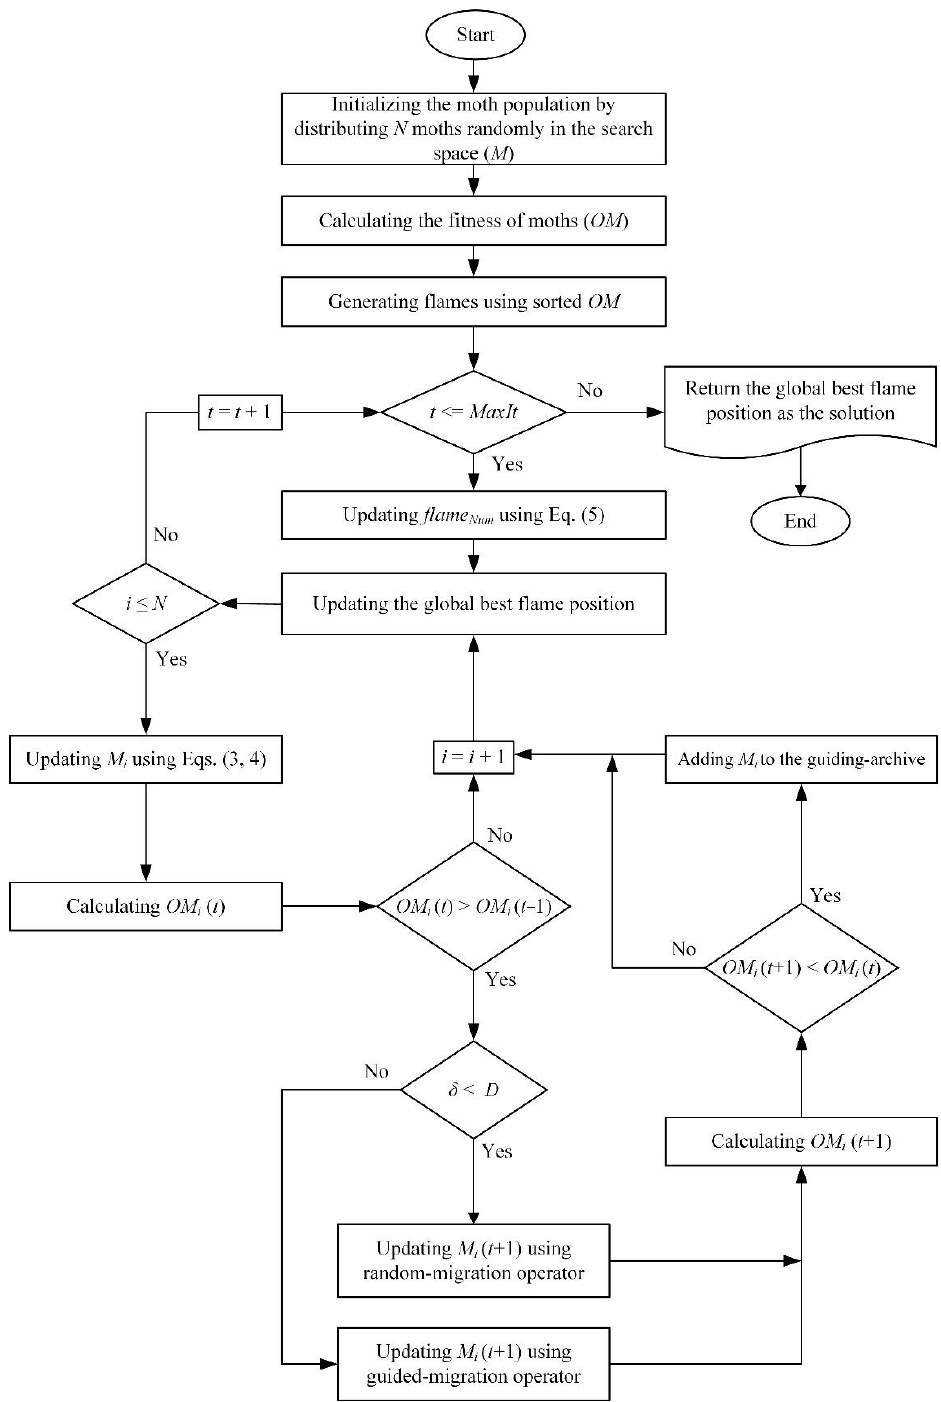
Figure 2. The flowchart of the proposed M-MFO algorithm.